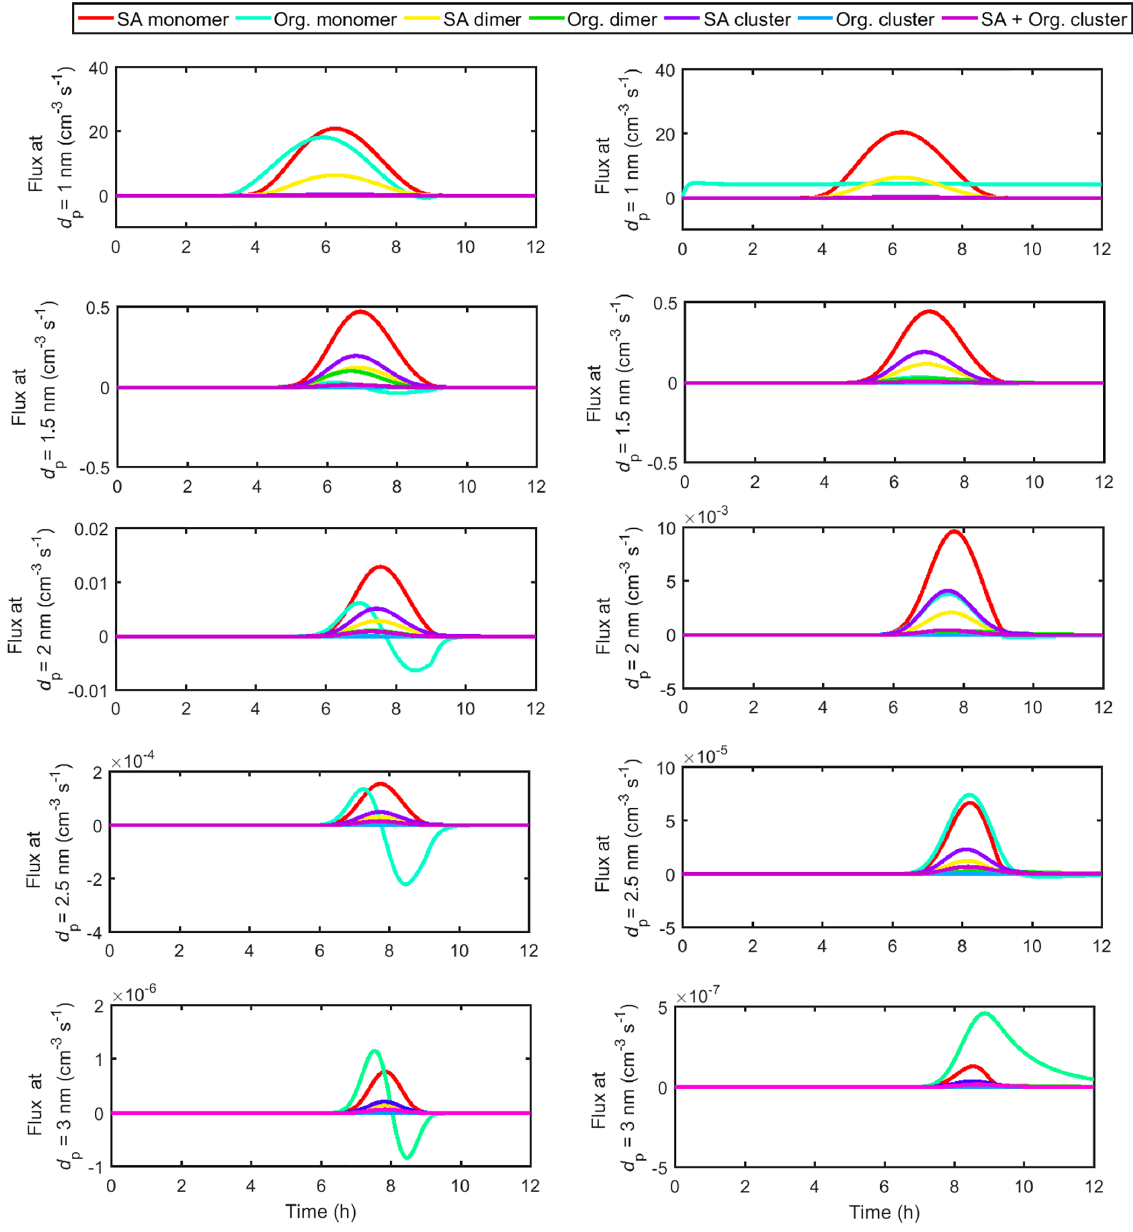
Figure A7. The net flux caused by different vapor monomers and clusters past certain threshold sizes in the simulations with time-dependent concentrations of SA–DMA and LVOC. The left and right panels correspond to the left and right panels in Fig.